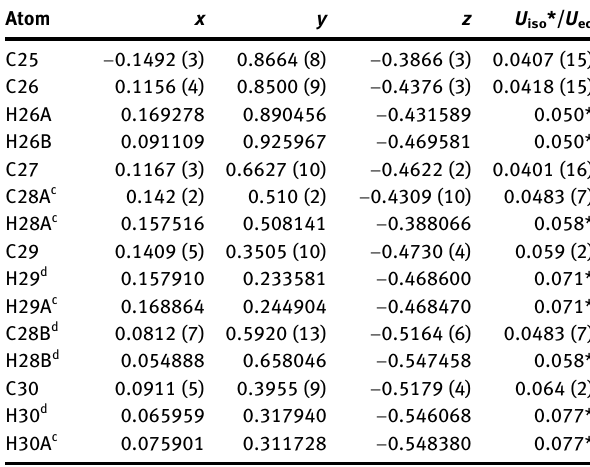
Table  : Fractional atomic coordinates and isotropic or equivalent isotropic displacement parameters (Å 